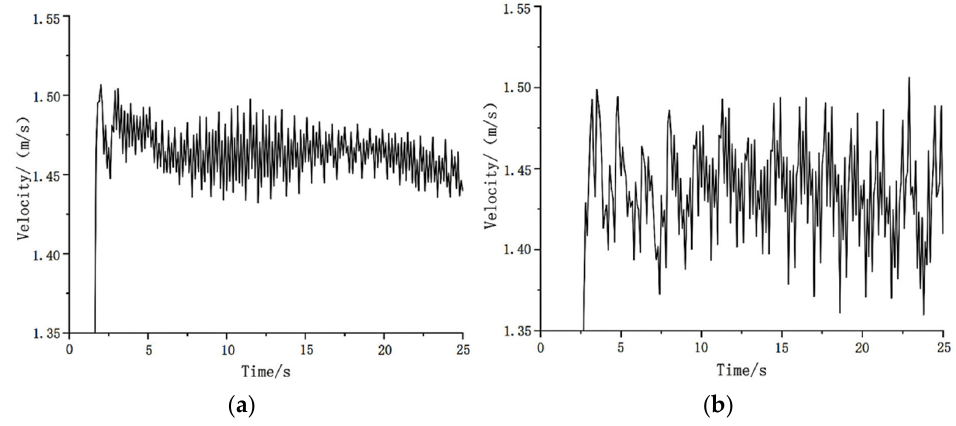
Figure 9. Driving speed simulation results: ( a ) Solid pavement and ( b ) Field